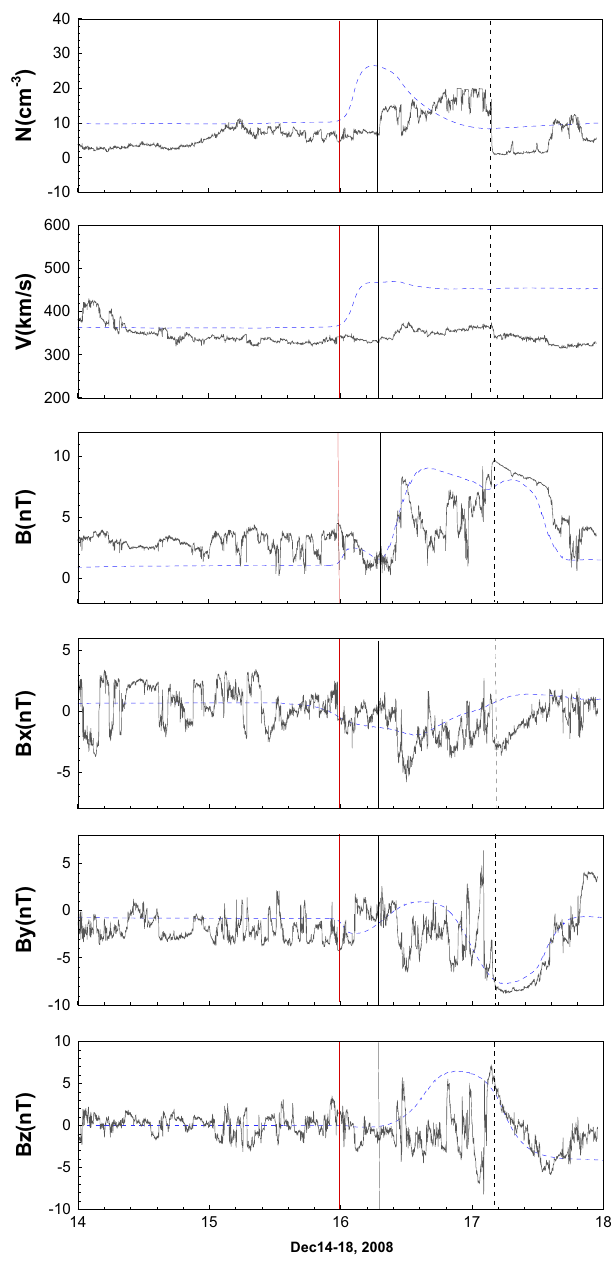
Fig. 11. Evolution of solar wind parameters at the Earth. Shown are number density, fl ow velocity, magnetic fi eld, and three components of magnetic fi eld in GSE coordinates. The simulated results at the Earth are shown by blue dot lines. The Wind observations are shown by black solid lines. The black vertical solid lines and dashed lines indicate the arrival time at 1 AU of the CME front and the magnetic cloud from observations, respectively. The red vertical solid lines indicate the arrival time at 1 AU of the CME front from model